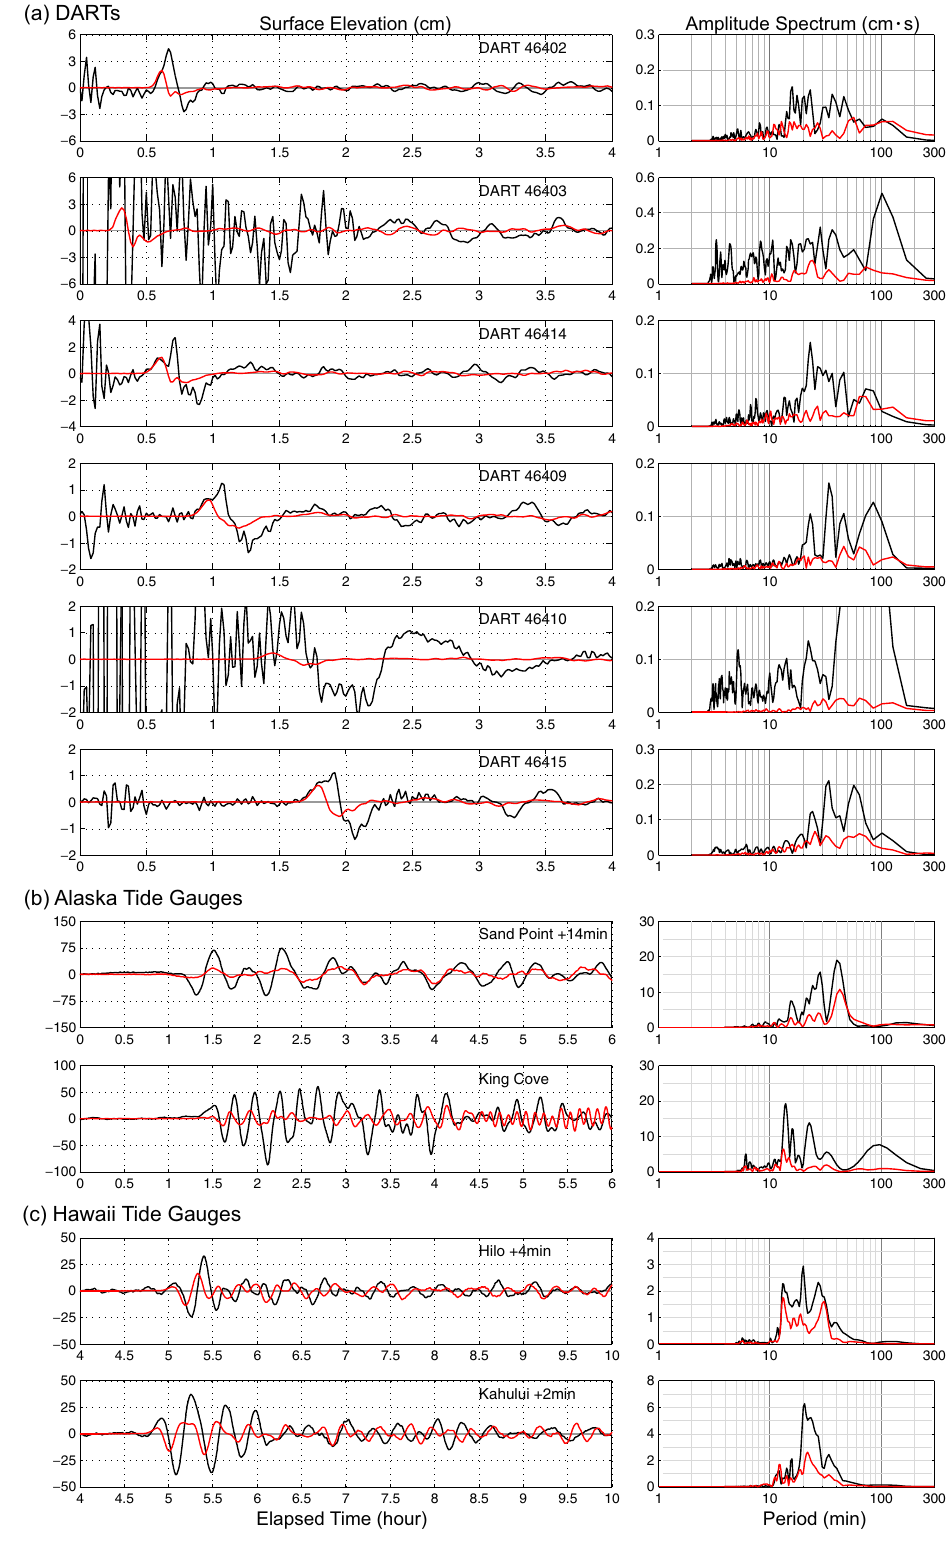
Fig. 4 | Tsunami predictions for the two-fault fast-slip model. Observed (black lines) and predicted (red lines) tsunami surface elevation time series (left column) and spectra (right column) for the two-fault model in Fig. 3 and Supplementary